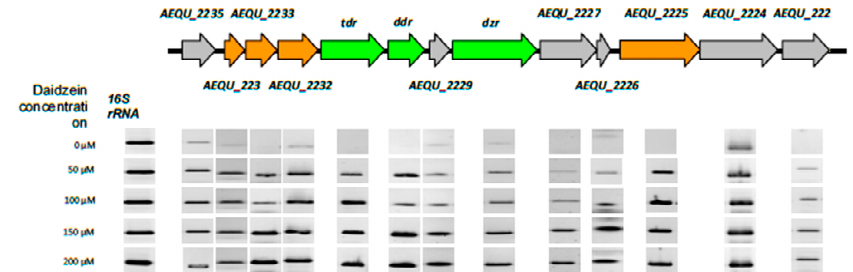
Figure 3. Schematic organization and RT-PCR analysis of genes in the equol biosynthesis cluster of